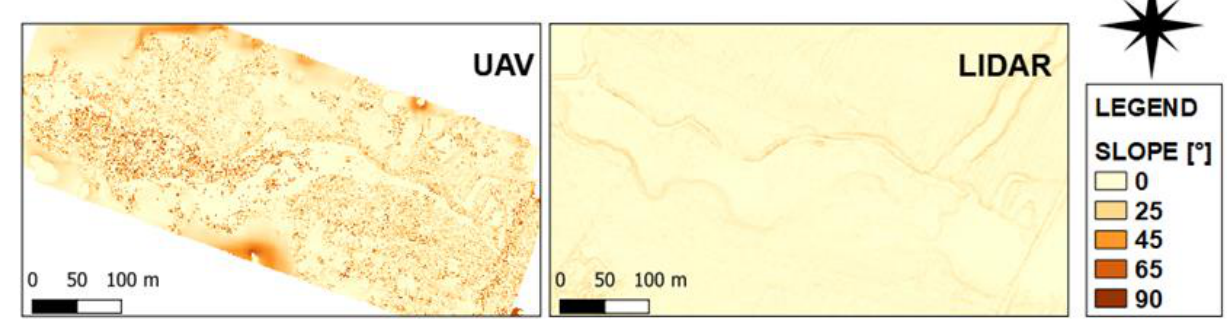
Figure 7. Slope map generated from the DEM created based on survey data using photogrammetric methods with the UAV and LIDAR; source: own elaboration.